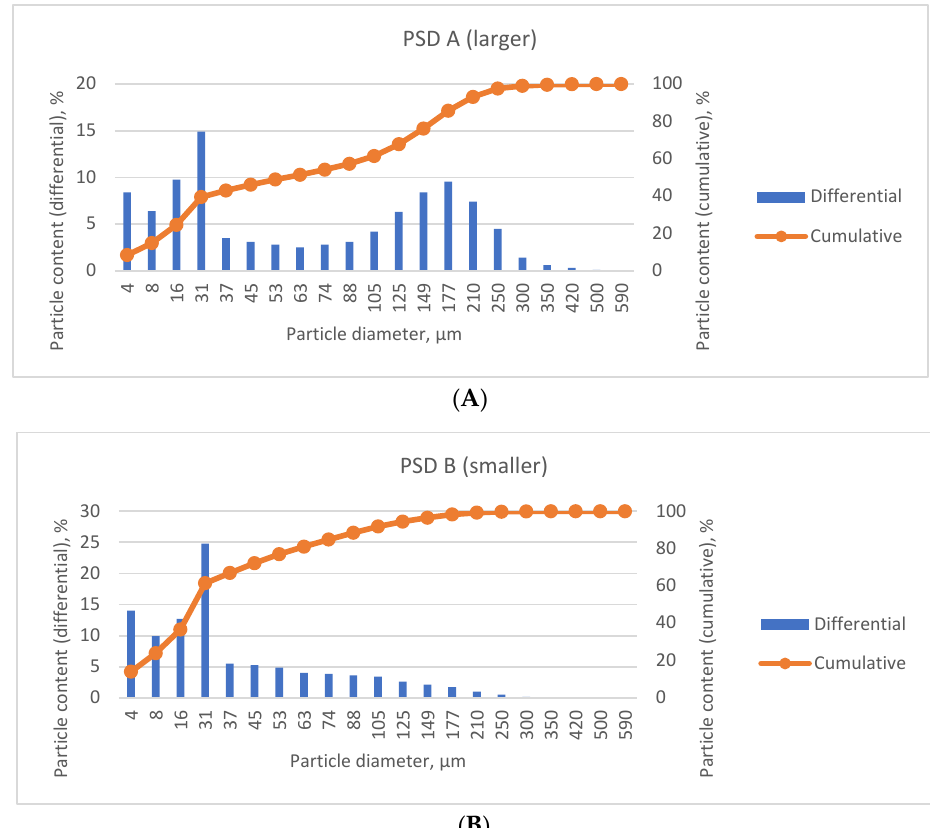
Figure 5. Reservoir particle size distribution curve: ( A )—larger PSD, ( B )—finer PSD.